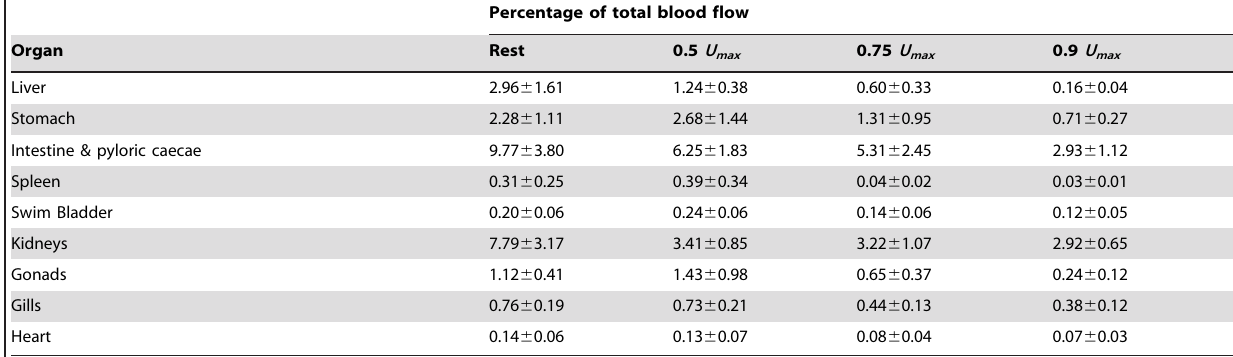
Table 1. Relative distribution of microsphere estimated blood flow to the